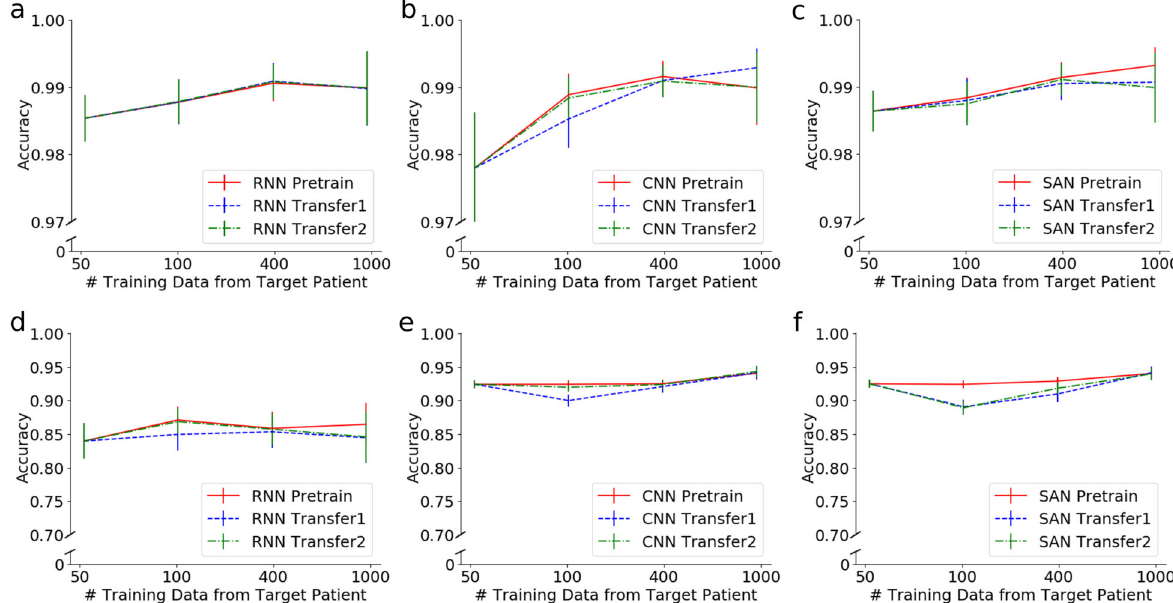
Fig. 2 Prediction accuracy comparison among different architectures (RNN, CNN, and SAN) with respect to the number of training data from the target patient in two classi fi cation tasks. a to c Prediction accuracy of the binary classi fi cation, i.e., identifying the neural network output as hypoglycemia or no hypoglycemia, using a RNN, b CNN, and c SAN. d to f Prediction accuracy of the three-class classi fi cation, i.e., identifying the neural network output as hypoglycemia or normoglycemia or hyperglycemia, using d RNN, e CNN, and f SAN. The data from a target patient is divided into two parts, one is for training and the other is for testing, and the prediction horizon is fi xed at 30 min. The accuracy of Transfer3 is lower compared to other transfer-learning methods. Here, CNN Pretrain and Transfer2 as well as SAN Pretrain show the best performance. Error bars (standard deviation, s.d.) are computed over all patients ’